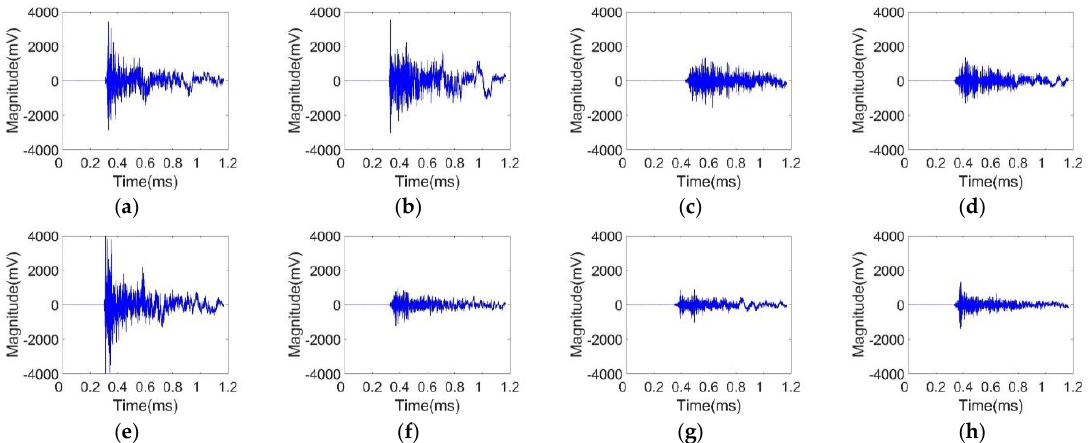
Figure 7. Time-domain impact signals for eight sensors: ( a ) sensor 1; ( b ) sensor 2; ( c ) sensor 3; ( d ) sensor 4; ( e ) sensor 5; ( f ) sensor 6; ( g ) sensor 7; ( h ) sensor 8.